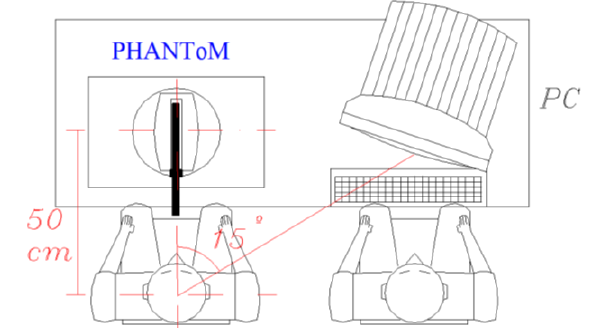
Figure 1. System used for objective characterization of the tremor by applying virtual